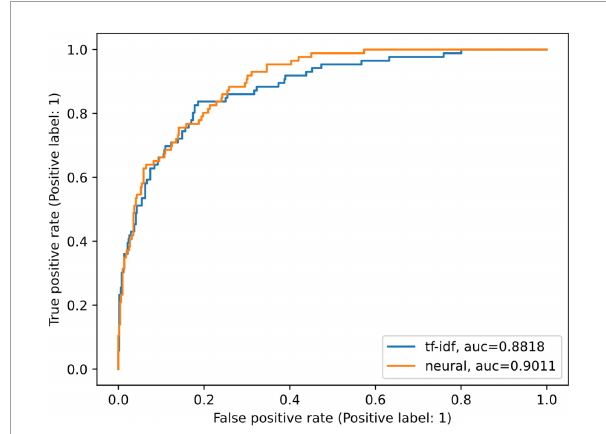
FIGURE2 Comparison of model ROC AUCs. AUC, area under the curve; ROC, receiver operating characteristic. ROC curves of the tf-idf weighted logistic regression model (blue) and the neural model with the best performance in the development set out of the five runs